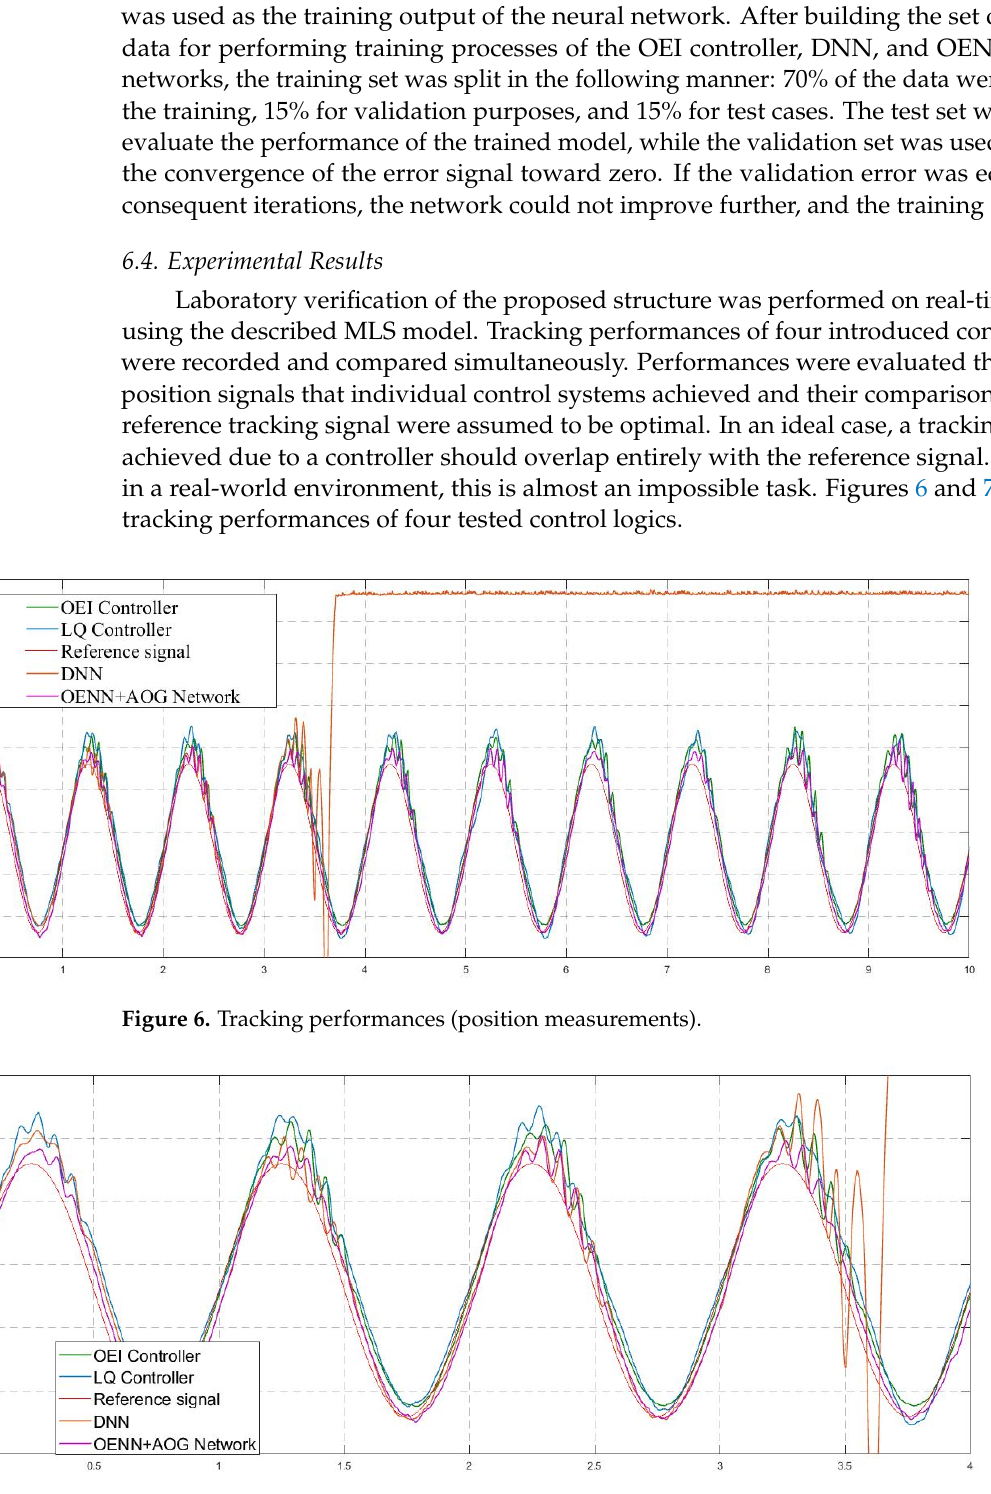
Figure 7. Enlarged view of part of the graph of tracking performances (position measurements).